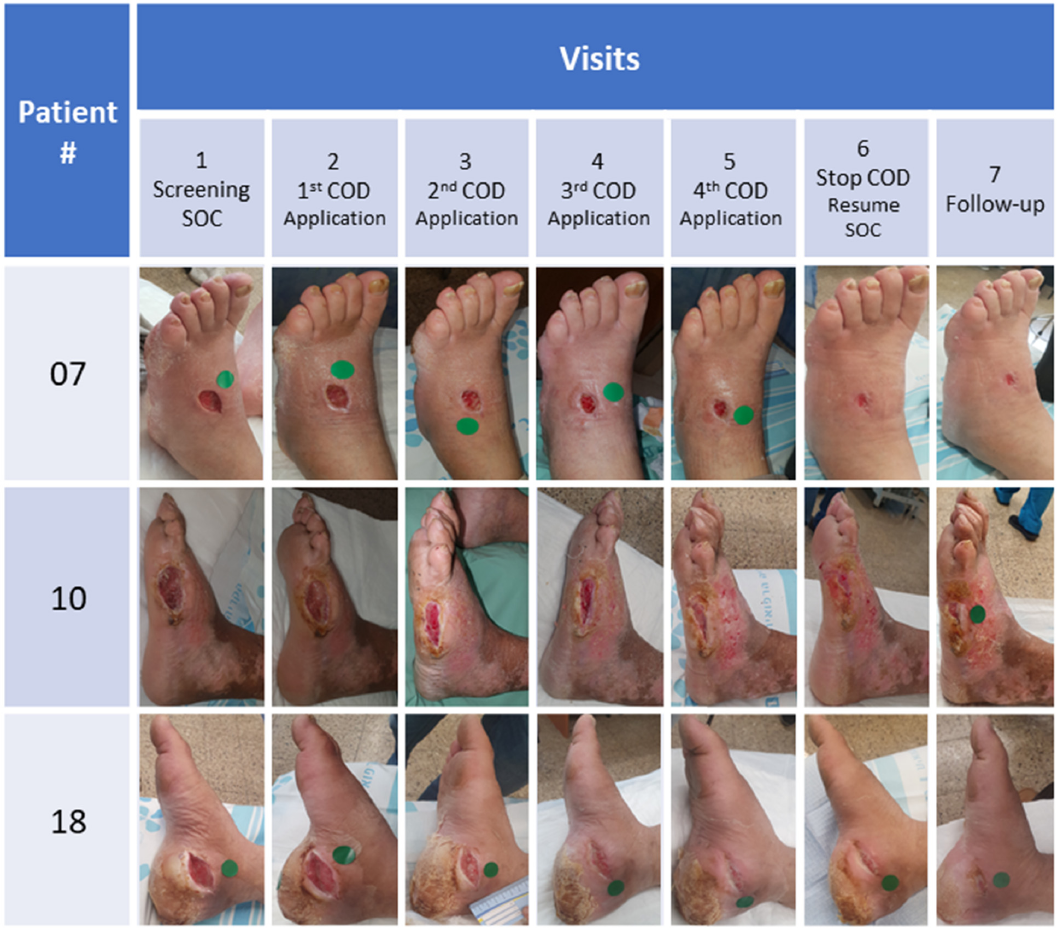
Figure 4. Pictures taken of the wounds throughout the study of 3 representative NWBW subgroups.